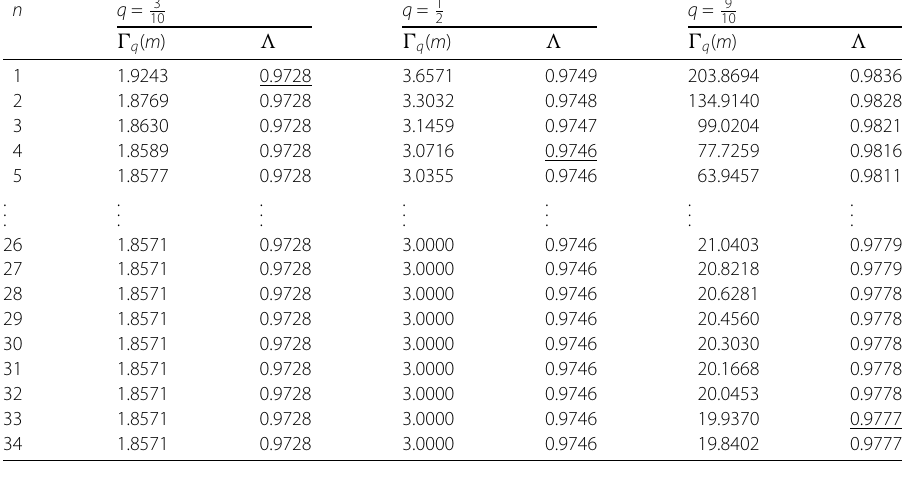
} in Example 5.1 , 1 , 9 10 2 10